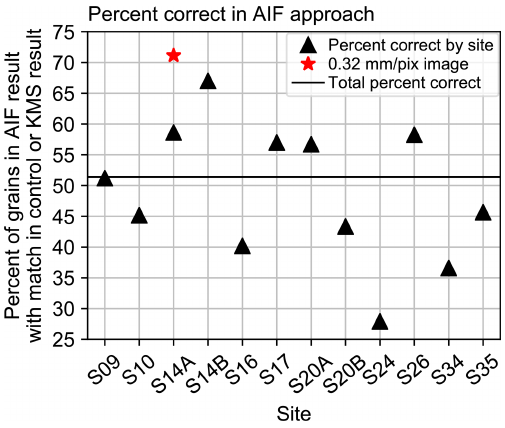
Figure 14. Percentage of grains from AIF results with a match- ing grain in either the hand-clicked control or in the KMS result. A match is defined as a grain within 5 pixels of the hand-clicked line or the KMS grain centroid for the 1.16mmpixel − 1 imagery or within 20 pixels for the 0.32mmpixel − 1 image (corresponding in both cases to a distance of ∼ 6mm), and with a 1cm maximum b -axis difference between the AIF grain and the match. The total percent correct, taken across all black triangles, is